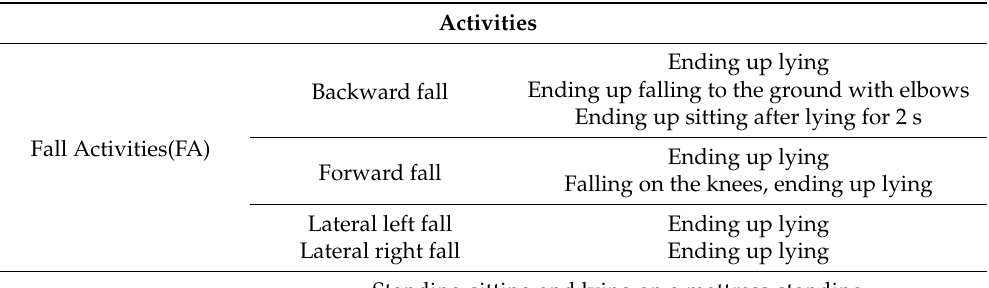
Table 1. Falls and ADL designed in the